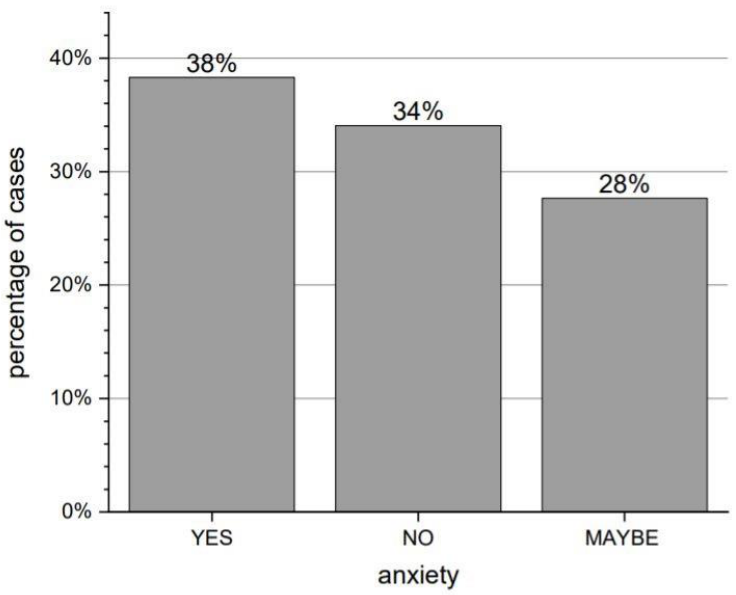
Figure 3. Distribution of answers to the question “Have you felt anxious since the beginning of the pandemic?”